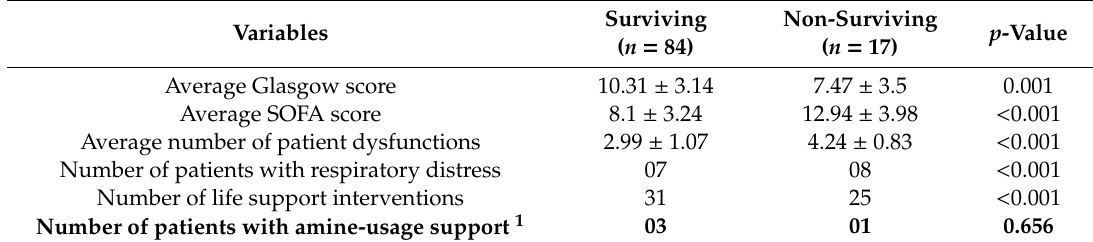
Table 4. Variables related to severity of clinical status and life support interventions for individuals hospitalized with severe malaria. Some patients received multiple life-support interventions.